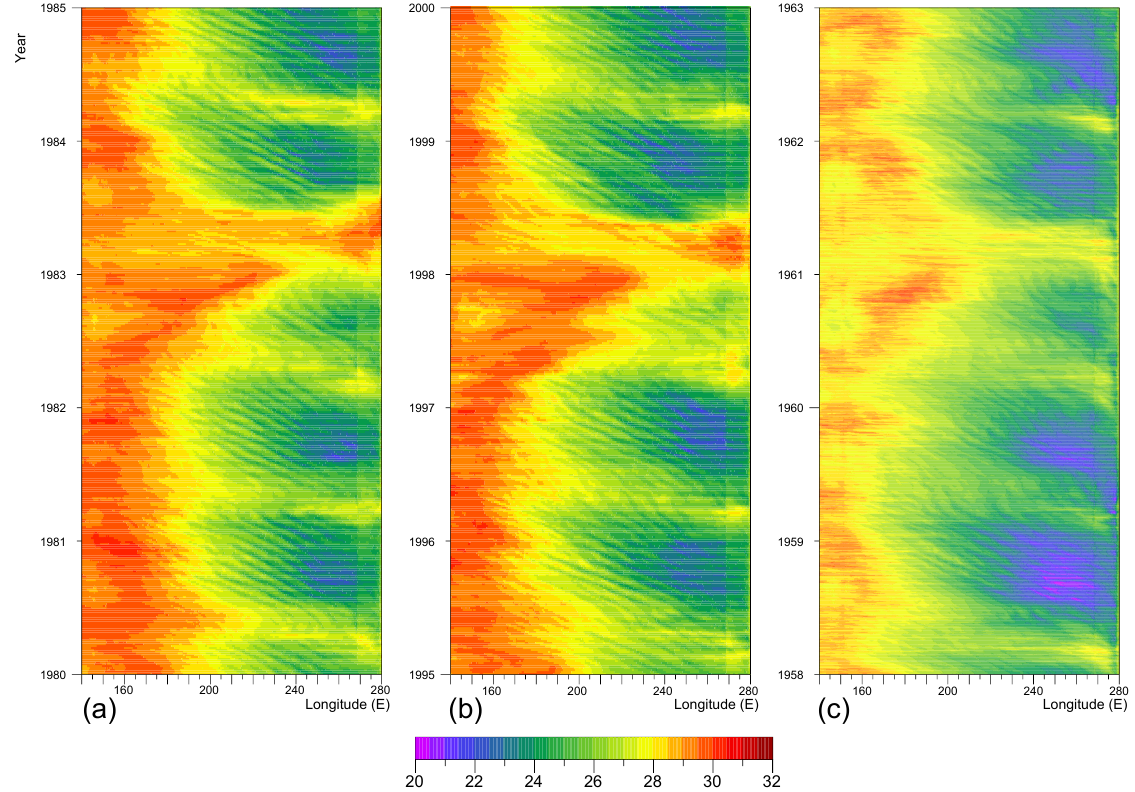
Figure 6. Expanded view of model sea surface temperature, averaged between 5 ◦ S and 5 ◦ N, for the equatorial Pacific between 120 and 280 ◦ E (80 ◦ W), and (a) between 1980 and 1985, (b) between 1995 and 2000, and (c) when coupled to a high-resolution atmospheric